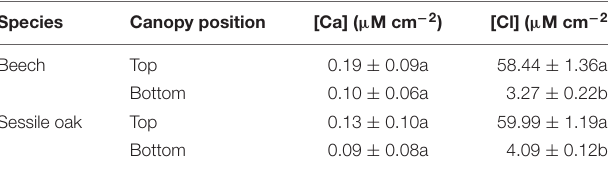
TABLE 6 | Calcium and Cl concentration ( µ M cm − 2 ) washed from the surface of untreated beech and sessile oak leaves collected from upper (top) or lower (bottom) tree canopy